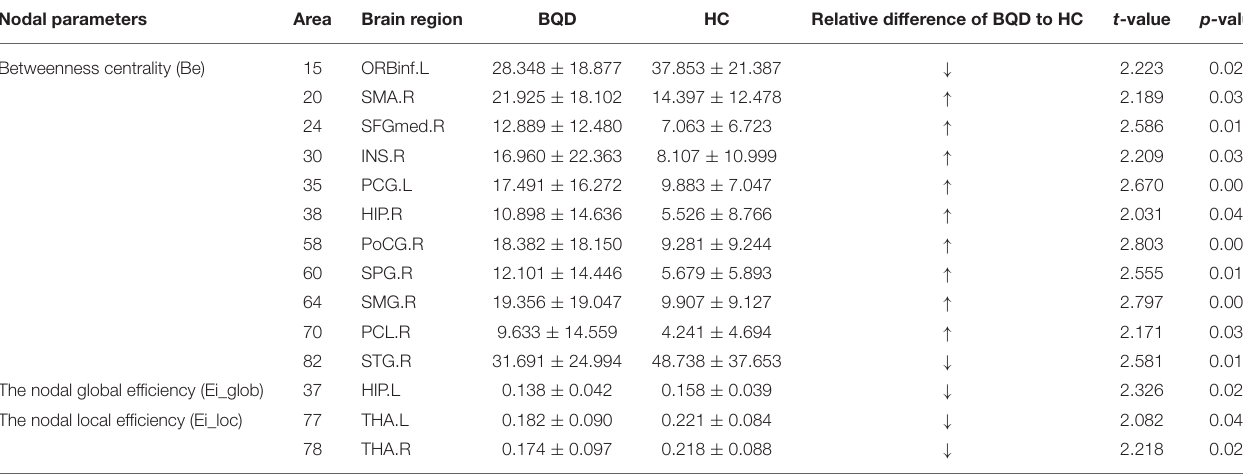
TABLE 4 | Comparison of nodal parameters of the whole brain functional connectivity network between BQD group and HC group. Nodal parameters Area Brain region BQD HC Relative difference of BQD to HC p- value Betweenness centrality